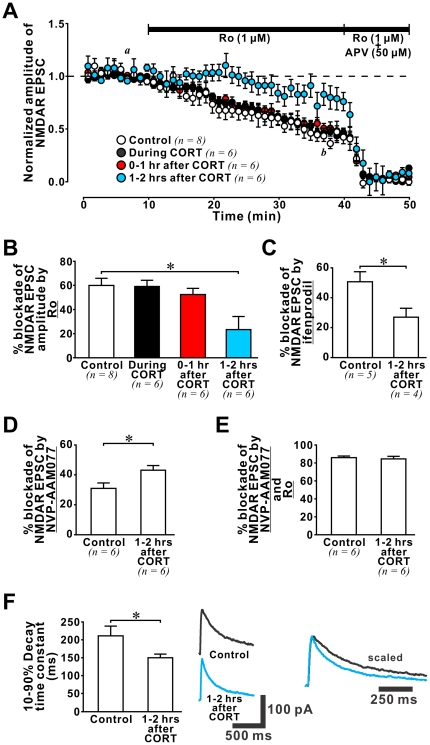
CORT triggered a slow-onset increase in GluN2A/GluN2B ratio.(A) Plots of NMDAR-EPSC amplitude from control and CORT-treated slices against time show decreased EPSC amplitude after sequential application of Ro (1 µM; for 30 min) and a mixture of Ro and a subunit non-selective NMDAR antagonist APV (50 µM; for 10 min). The dashed line represents 100% normalized NMDAR-EPSC amplitude. Note that Ro produced significantly smaller blockade of NMDAR-EPSCs recorded in 1–2 hrs after CORT slices (blue circles). (B) Histogram summarizes the percentage blockade of Ro in slices from 4 different groups. * p<0.05: post-hoc Fisher's test after ANOVA. (C) Histogram summarizes the percentage blockade by ifenprodil (1 µM), another GluN2B antagonist, in NMDAR-EPSCs recorded in control and 1–2 hrs after CORT slices. Note that ifenprodil produced significantly smaller blockade of NMDAR-EPSCs recorded in 1–2 hrs after CORT slices. * p<0.05: student's t-test. (D) Histogram summarizes the percentage blockade by NVP-AAM077 (50 nM), a GluN2A antagonist, in NMDAR-EPSCs recorded in control and 1–2 hrs after CORT slices. Note that NVP-AAM077 produced significantly greater blockade of NMDAR-EPSCs recorded in 1–2 hrs after CORT slices. * p<0.05: student's t-test. (E) Histogram summarizes the percentage blockade by a cocktail of NVP-AAM077 and Ro in NMDAR-EPSCs recorded in control and 1–2 hrs after CORT slices. Note the similar blockade of NMDAR-EPSCs in control and 1–2 hrs after CORT slices. (F) Left: Histogram summarizes the 10–90% decay time constant of evoked NMDAR-EPSCs recorded in control and 1–2 hrs after CORT slices. Note that the decay time constant of NMDAR-EPSC recorded from 1–2 hrs after CORT slices was significantly smaller than that from control slices. * p<0.05: student's t-test. Middle: Representative traces of evoked NMDAR-EPSC recorded from control and 1–2 hrs after CORT slices. Right: Traces were peak-scaled to illustrate the faster decay property of NMDAR-EPSCs in 1–2 hrs after CORT slices.